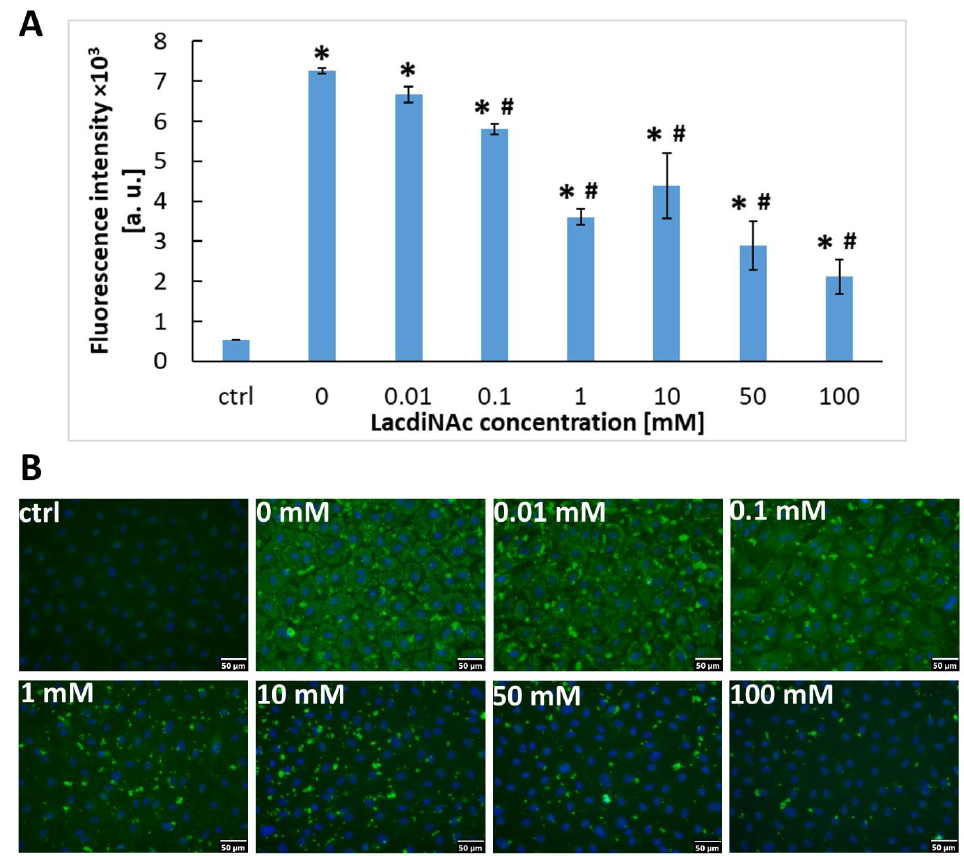
Figure 3. HUVECs after 1 h of incubation in a cultivation medium containing Gal-3 (30 μM) and various concentrations of LacdiNAc (0–100 mM). Control cells were incubated with a pure cultivation medium without Gal-3 and LacdiNAc. ( A ) Intensity of the fluorescence signal in HUVECs stained for Gal-3 (ex./em. = 485/528 nm). The data are shown as the mean ± SD from 3 wells. Holm-Sidak test, p ≤ 0.05. * Statistically significant difference in comparison with the control cells in the pure cultivation medium (ctrl). # Statistically significant difference in comparison with cells without LacdiNAc (0). ( B ) Immunofluorescence of Gal-3 in the cells compared in graph A. Anti-Gal-3 antibody (EP2775Y) produced in rabbits (Abcam, Cambridge, UK; Cat. No. ab76245) was used. The cell nuclei were counterstained with Hoechst 33258. Olympus IX 71 microscope, DP 70 digital camera, obj. 20×, scale bar 50 μm.